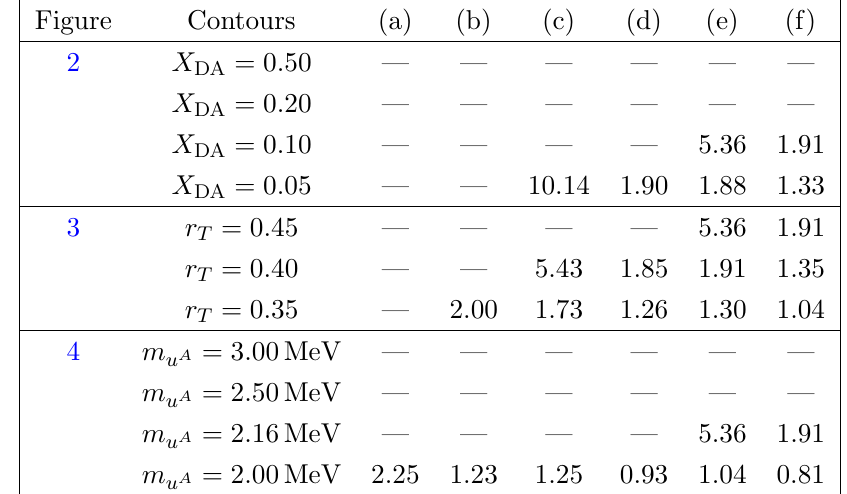
Table 1. Maximum value of tan (cid:12) A than can accommodate X DA below 10% for each contour (or corresponding values in the case of (cid:12)gure 2). An empty entry means that no such limit exists. One thing that might not be entirely clear from these plots is that, for a (cid:12)xed tan (cid:12) A , going to an arbitrarily large tan (cid:12) B = tan (cid:12) A is not necessarily su(cid:14)cient to bring X acceptable level. As such, the maximum tan (cid:12) A that can accommodate X corresponding values in the case of (cid:12)gure 2) is presented in table 1 for all relevant (cid:12)gures. As a general rule, Type II performs better than Type Y. This is simply because,